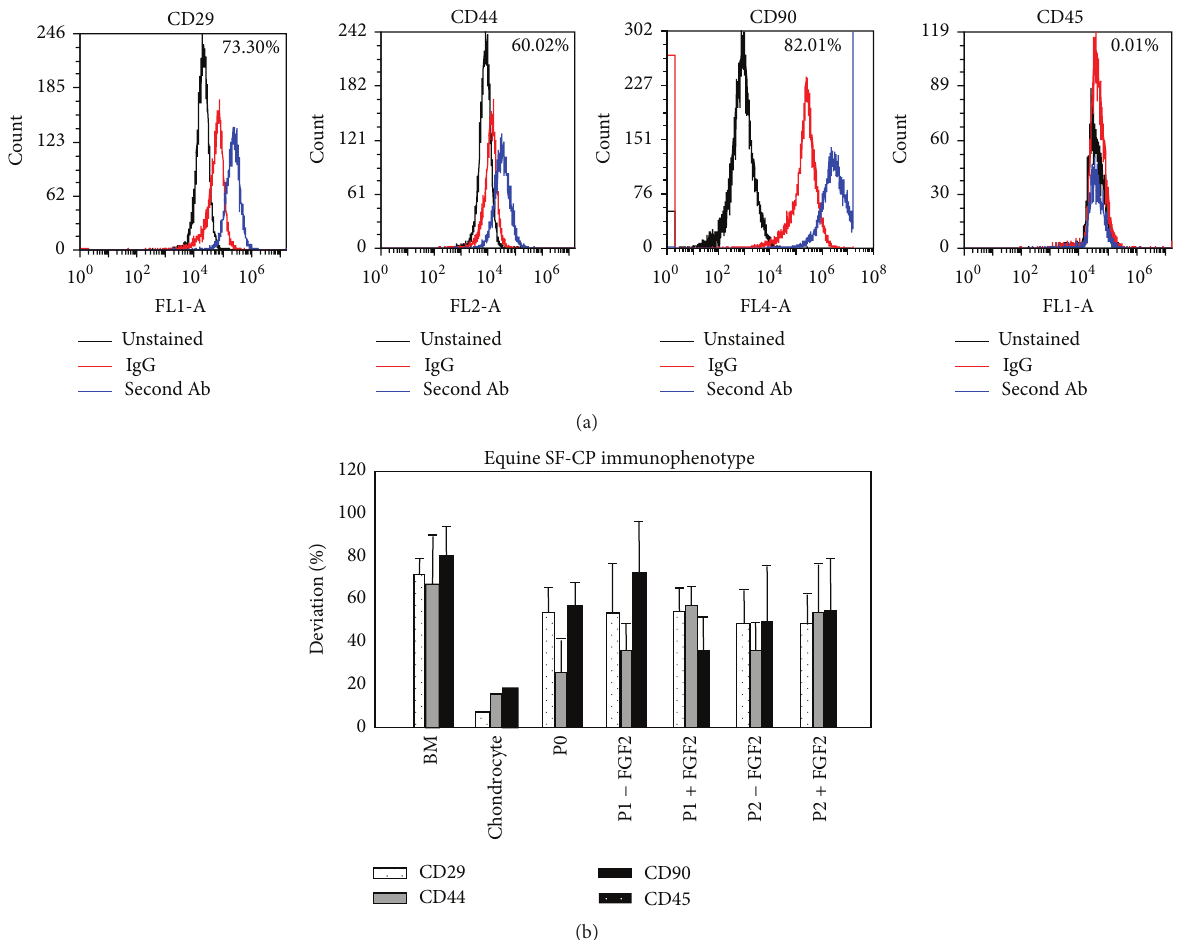
Figure 2: SF-CP immunophenotype characterization. (a) Representative immune-phenotypic profile of passage 1 SF-CPs (horse 2), supplemented with FGF-2. (b) Immunophenotypic characterization (mean ± SD) of SF-CPs at passages 0, 1, and 2, along bone marrow (BM) MSCs and chondrocyte control populations ( 𝑛 = 8